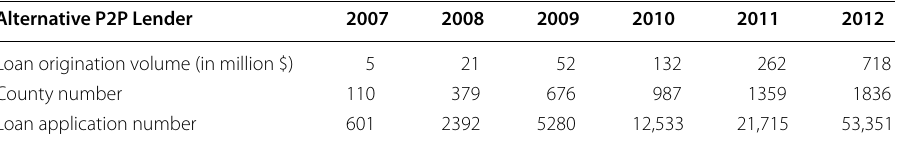
Table 1 demonstrates the number of a total loan application, total loan origination volume of Lending Club and give details the total number of counties where it served between 2007 and 2012